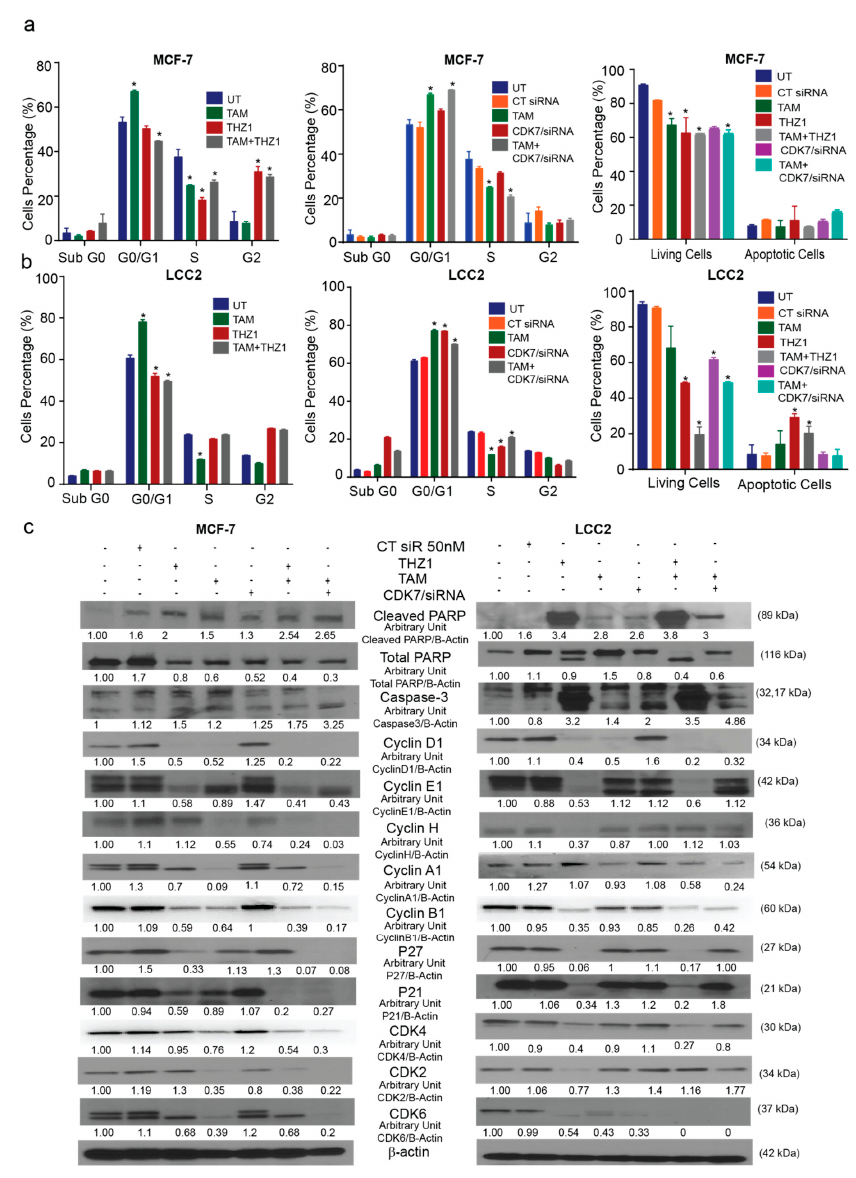
Figure 4. Effects of CDK7 inhibition combined with tamoxifen on the cell cycle and apoptosis. ( a ) Histograms showing the results of the flow cytometry analysis of the cell cycle and apoptosis assays of MCF-7 cells. (Left) Cell cycle analysis of MCF-7 cells treated with the indicated concentrations of tamoxifen, THZ1, and their combination. (Center) Cell cycle analysis of MCF-7 cells treated with the indicated concentrations of tamoxifen, CT siR, CDK7 siR, and the combination of tamoxifen plus CDK7 siR. (Right) Percentage of living and apoptotic MCF-7 cells treated with the indicated treatments. ( b ) Histograms showing results of flow cytometry analysis of the cell cycle and apoptosis assays of LCC2 cells. (Left) Cell cycle analysis of LCC2 cells treated with the indicated concentrations of tamoxifen, THZ1, and their combination. (Center) Cell cycle analysis of LCC2 cells treated with the indicated concentrations of tamoxifen CT siR, CDK7 siR, and the combination of tamoxifen plus CDK7 siR. (Right) Percentage of living and apoptotic LCC2 cells treated with the indicated treatments. ( c ) Western blots of cell cycle and apoptosis markers in cells exposed to tamoxifen, THZ1, and CDK7 siR, individually and in combination. For Western quantification imageJ software was used to measure the intensity and normalize each value to its corresponding β -actin. Results in the graphs are expressed as mean ± SD of two independent experiments performed in triplicate. Statistical significance was determined by one-way ANOVA using the Tukey multiple comparison test. * p < 0.05. UT,